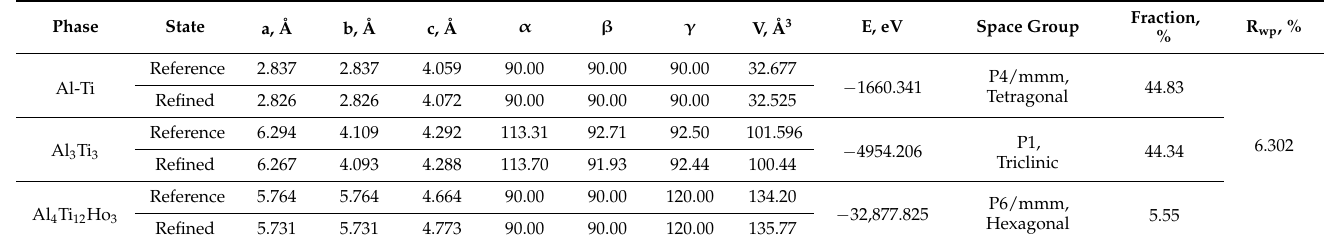
Table 1. Structural parameters of the lattices in the TAH alloy.